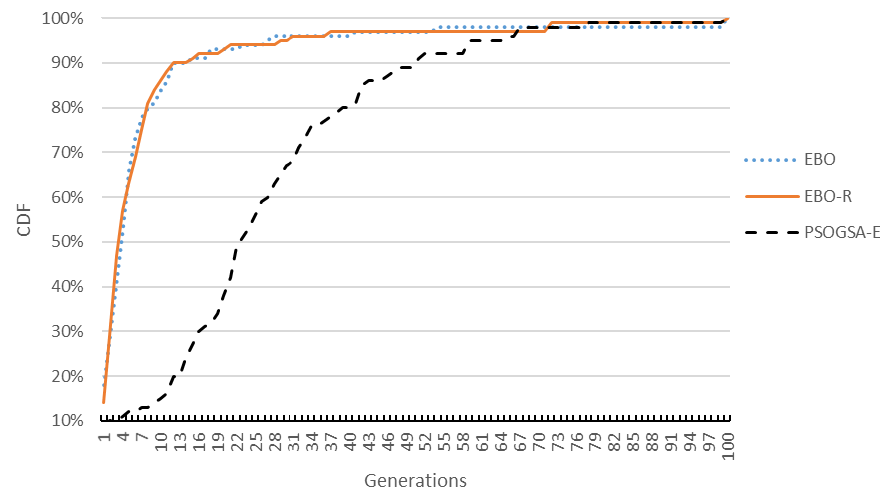
Figure 12. Cumulative distribution function (CDF) comparisons of different algorithms.